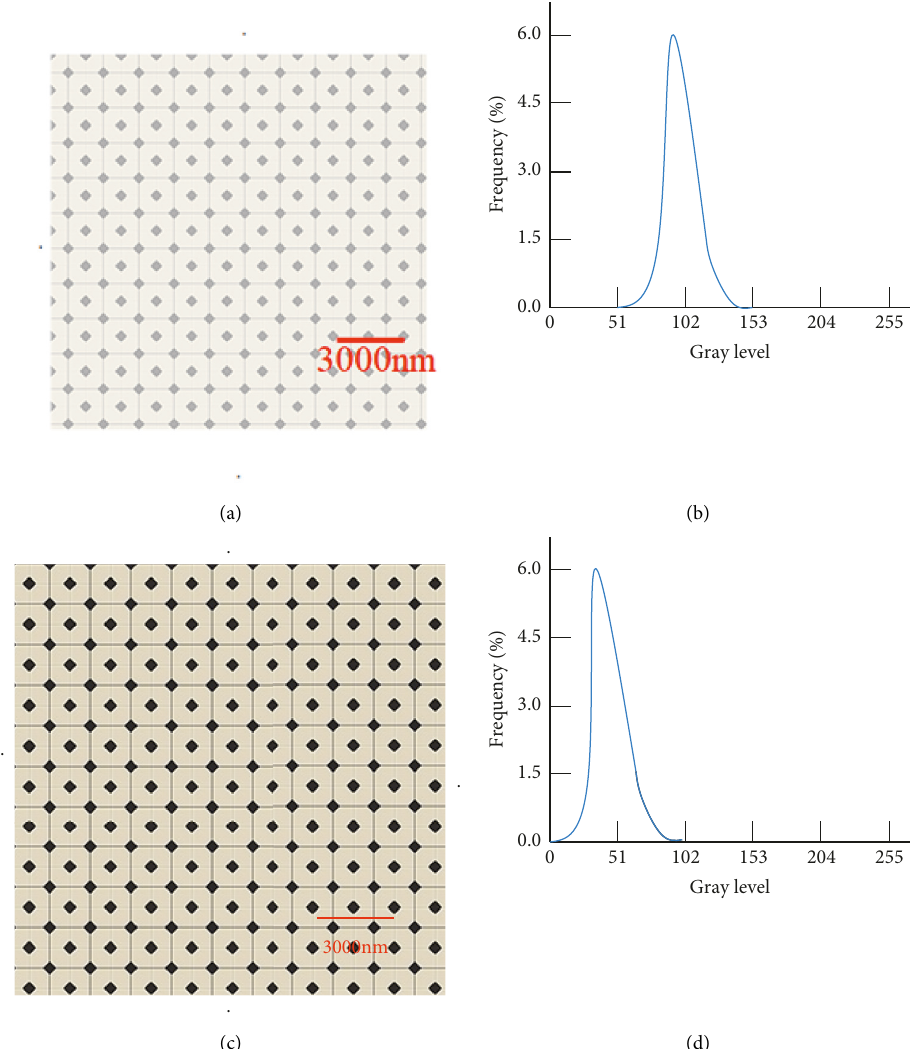
Figure 3: Imagebrightness adjustment. (a) Original image, (b) original grayscale histogram, (c) image after the brightness adjustment, and (d) the brightness-adjusted grayscale